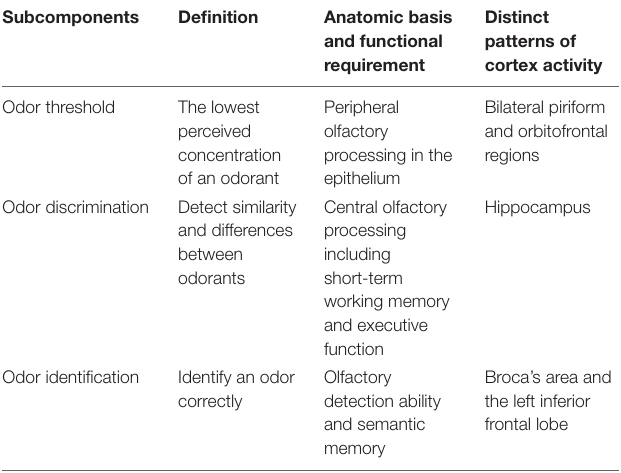
TABLE 2 | Anatomic basis and functional requirement of olfactory